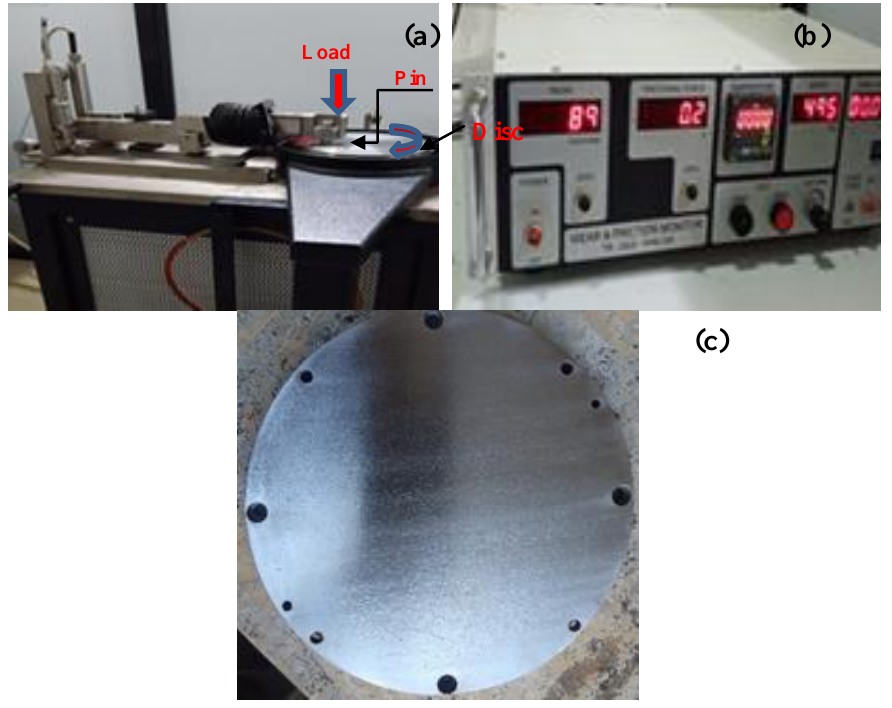
Fig. 3. (a) Pin on Disc apparatus, (b) Data acquisition system and (c) Disc (made of gray